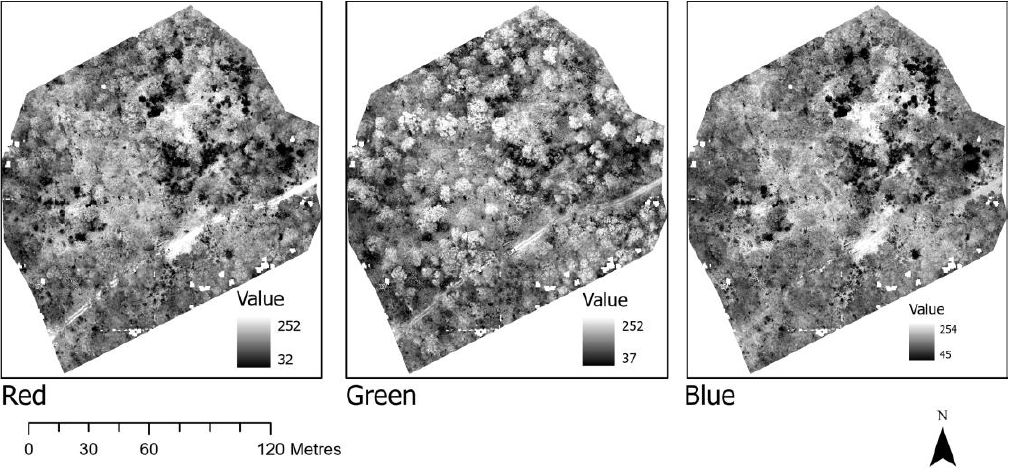
Figure 4. Separation of the orthomosaic into red, green and blue spectrum.